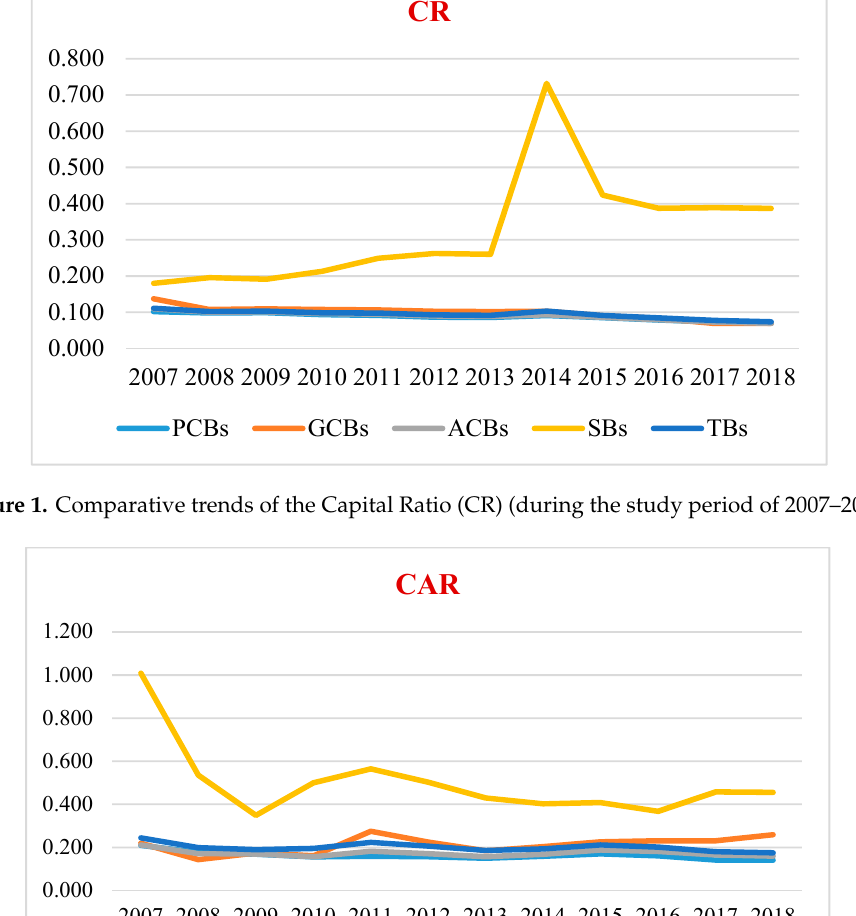
Figure 3. Comparative trends of Minimum capital requirement (MCR) (during the study period of 2007–2018). A downward trend is observed in the CRs of all banks except for SBs (see Table 3 and Figure 1). The CRs of PCBs and GCBs decreased to 7.0% and 6.9% in 2018 from 10.2% and 13.7% in 2007, respectively. On the other hand, the CRs of ACBs decreased to 6.9% in 2018 from 11% in 2007, while the CRs of SBs increased to 38.7% in 2018 from 18% in 2007. Overall, the CRs of the banking industry (TBs) also decreased to 7.4% in 2018 from 11.1% in 2007. The downward trend in the CR indicates that the Pakistani banking industry was either changing its patterns towards relying more on deposits or facing decreasing profitability ratios during the study period, as reported by Yao et al. (2018). The t -test comparison indicates that the GCBs have comparatively higher average CRs (0.104) than the average CRs (0.101) of the PCBs, although the difference is insignificant. The SBs have a higher average CR (0.349) than the overall average CR (0.101), which represents a significant difference at a 1 percent level (see Table 4). Overall, we find that the capitalized position, when measured by CR, of government-owned banks (GCBs and SBs) is stronger than that of privately- owned banks (PCBs). Each bank operating in Pakistan must maintain a minimum CAR as specified by the SBP. Table 5 reports the CAR requirements of the SBP 4 for the period from 2007 to 2018. Although the analysis indicates fluctuations in CAR, it shows that all types of banks have maintained their CARs higher 4